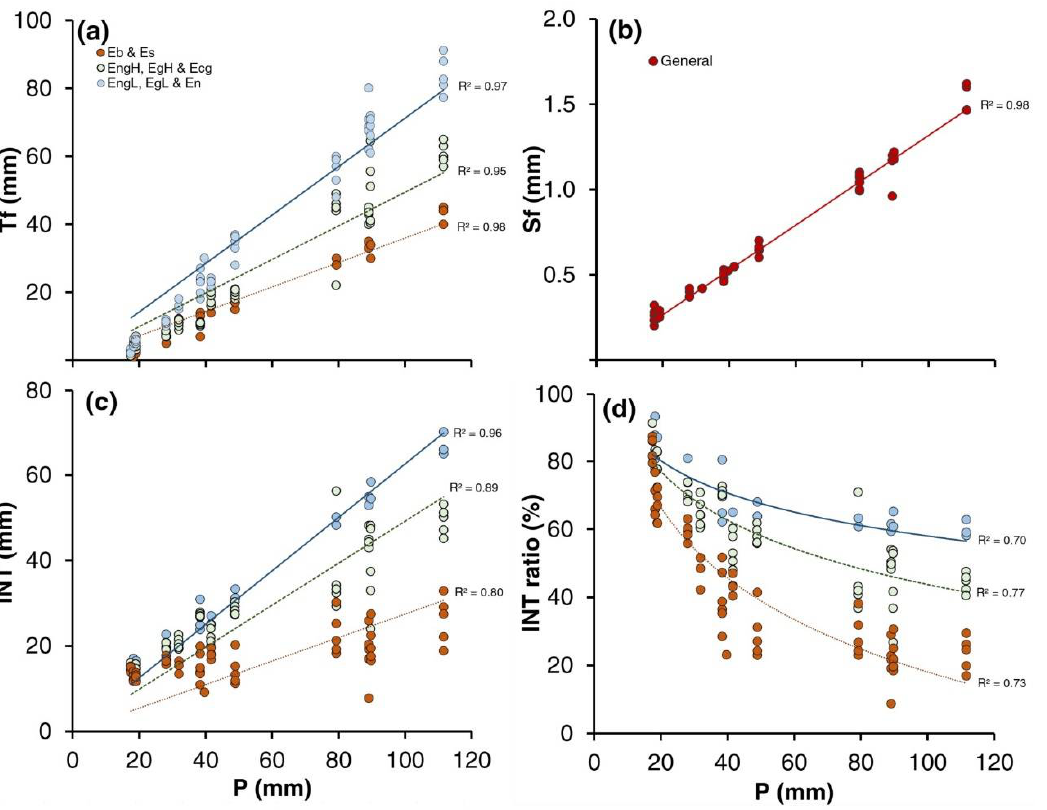
Figure 2. Throughfall (Tf) ( a ), Stemflow (Sf) ( b ), Rainfall interception (INT) ( c ) and Rainfall interception ratio (INT ratio) ( d ) as a function of precipitation (P) for genotypes of Eucalyptus. Lines in each figure indicate the behavior trend of each group of genotypes.